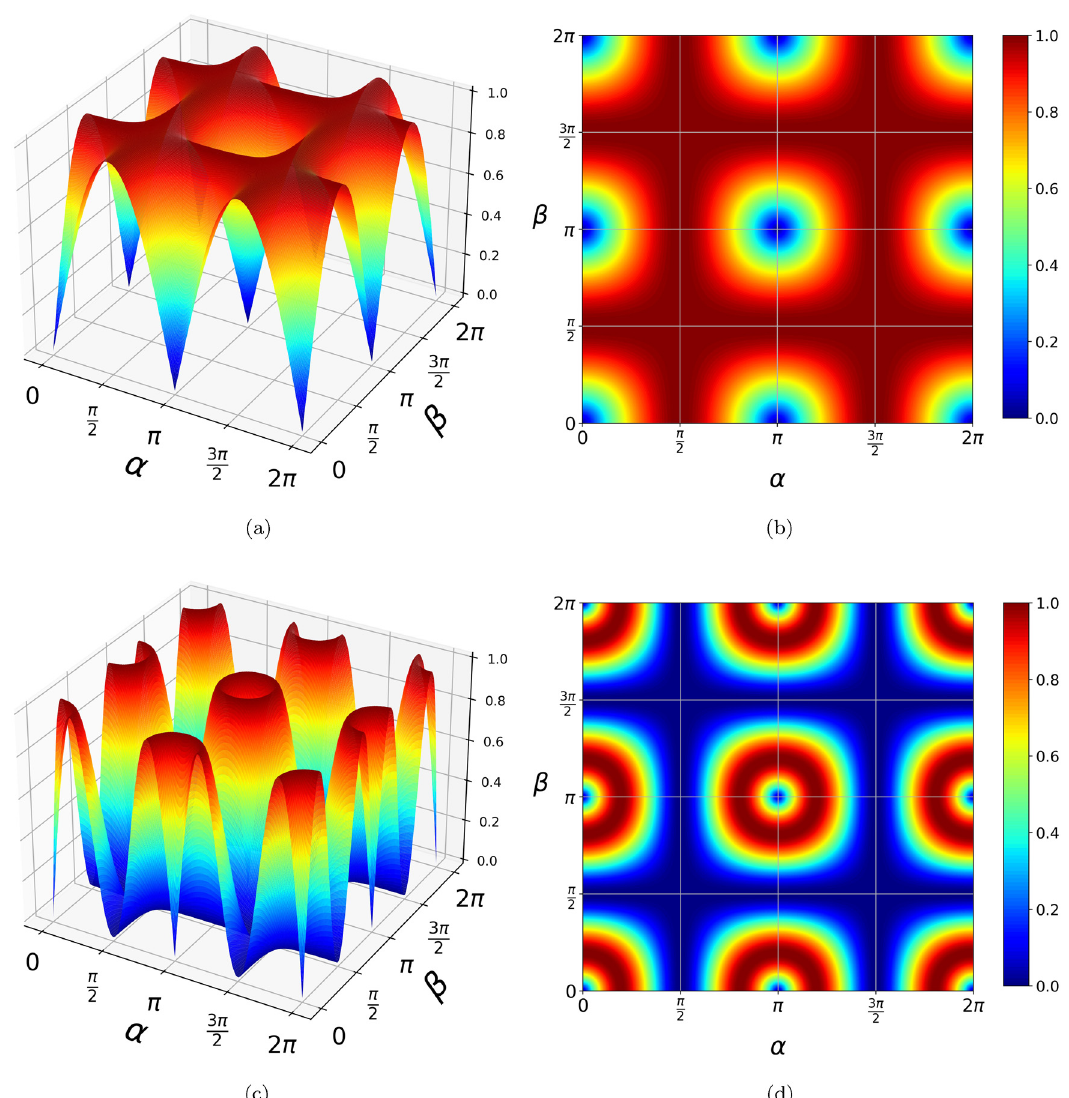
Figure 4: Solution spaces for planes and cylinders α β π , 0, 2 [ ] ∈ from equations ( 15 ) and ( 17 ) , respectively. ( a ) 3D - graph for cylinders. ( b ) Contour for cylinders. ( c ) 3D graph for planes. ( d ) Contour for planes.